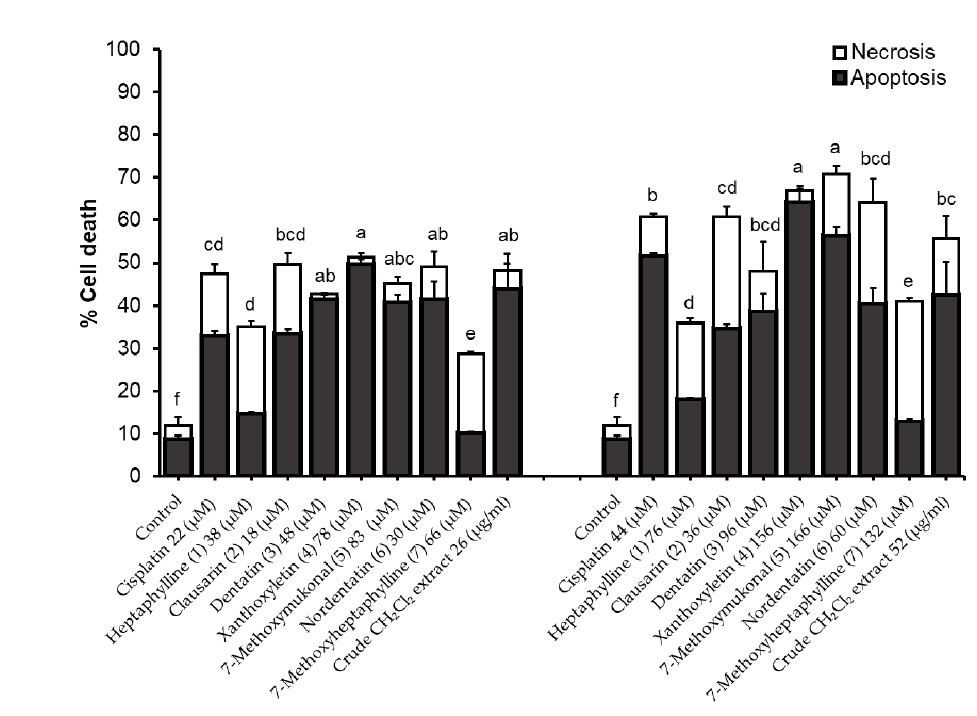
Figure 3. Apoptosis ( (cid:4) ) and necrosis ( (cid:3) ) death modes induced by the isolated compounds and crude dichloromethane extract from C. harmandiana at 1 × IC 50 and 2 × IC 50 concentrations against HepG2 cell line at ( a ) 12 h and ( b ) 24 h. Control is the untreated cells and cisplatin was used as a positive chemotherapeutic drug. The apoptotic cell percentage in each treatment groups are expressed as the mean ± SD of three experiments and were analyzed by Kruskal Wallis nonparametric statistics. Different lower-case letters indicate a significant difference of apoptosis percentage induced between compounds ( p < 0.05).